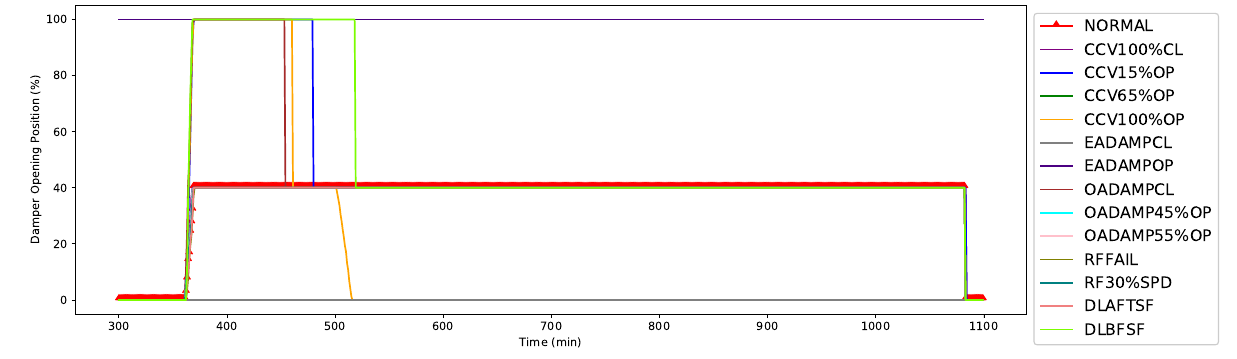
Figure 6. Third-top feature: Exhaust air damper (EA-DMPR).